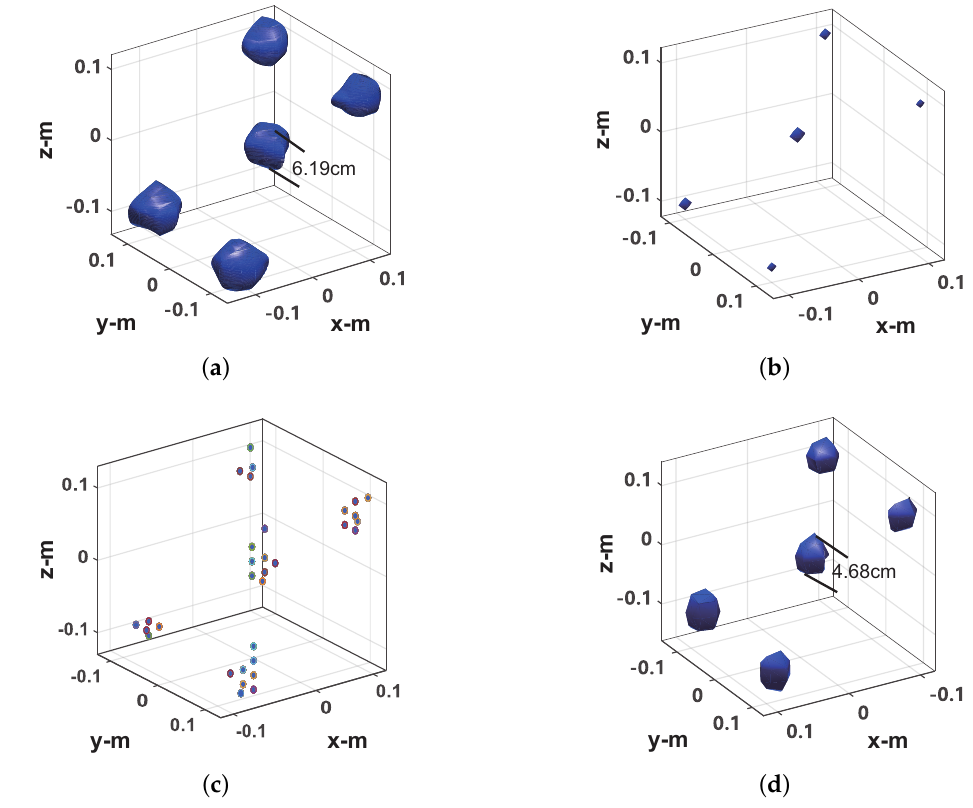
Figure 11. Imaging results from 100% sampled data. ( a ) Frequency interpolation method. ( b ) OMP-CS method. ( c ) (cid:96) 1 -TV-CS method. ( d ) Proposed